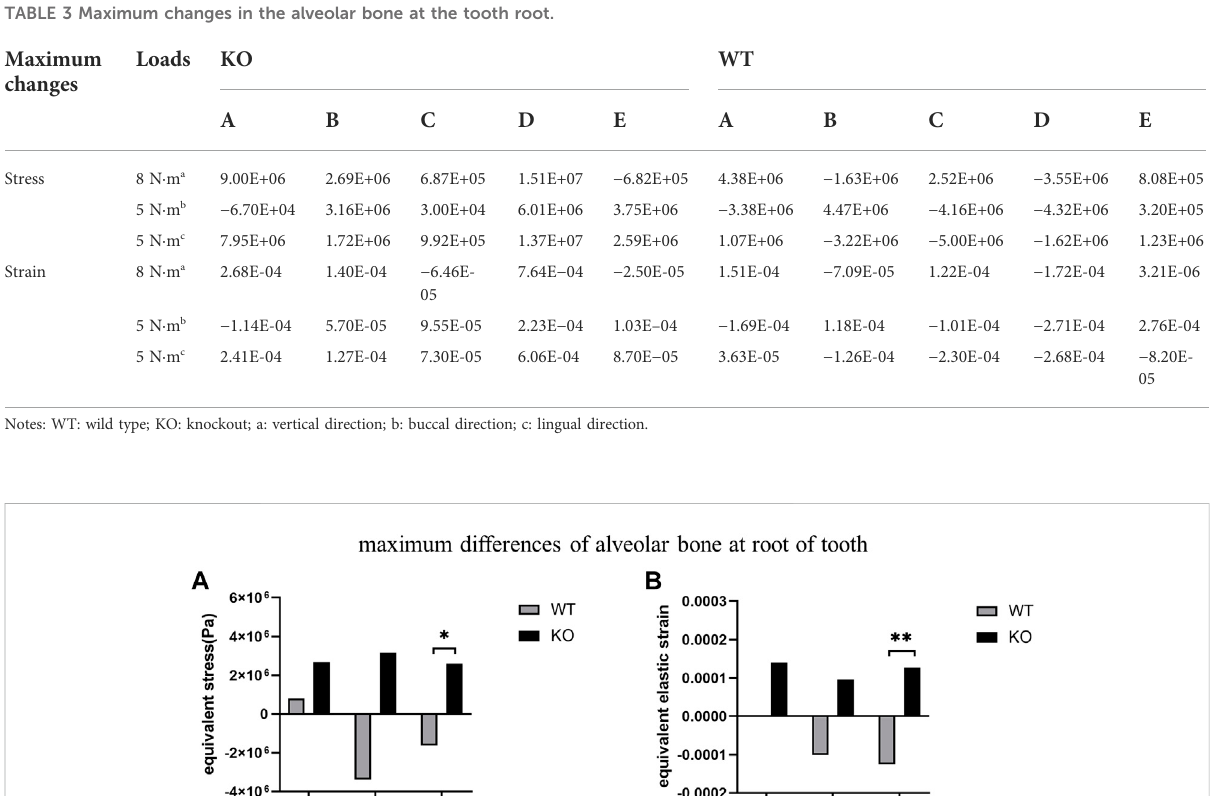
TABLE 3 Maximum changes in the alveolar bone at the tooth root.